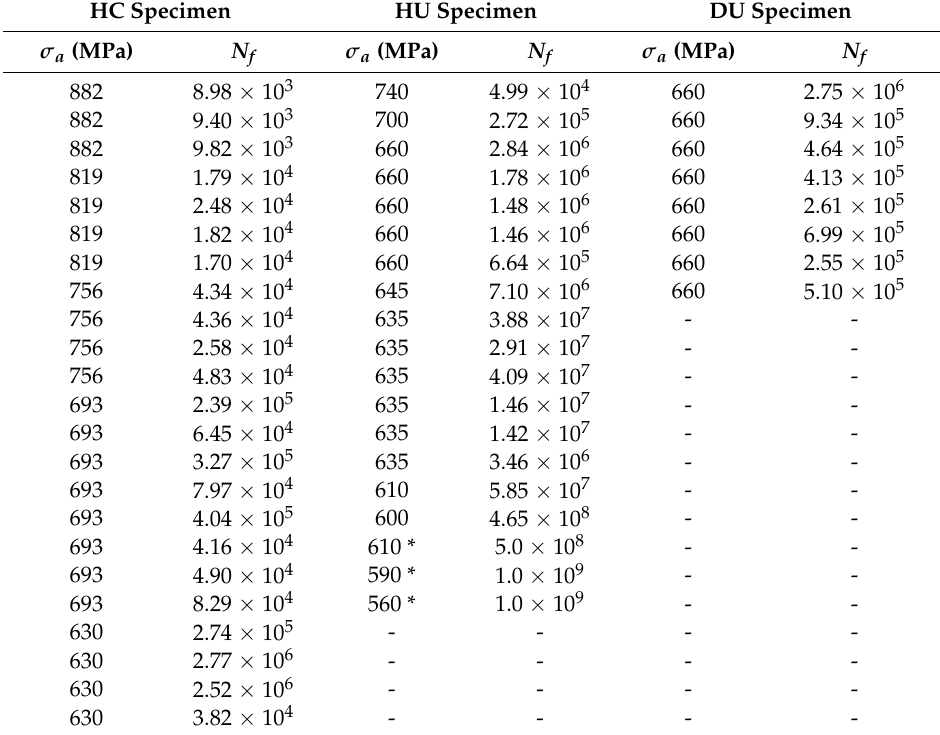
Table 1. Original experimental data from the specimens shown in Figure 5.